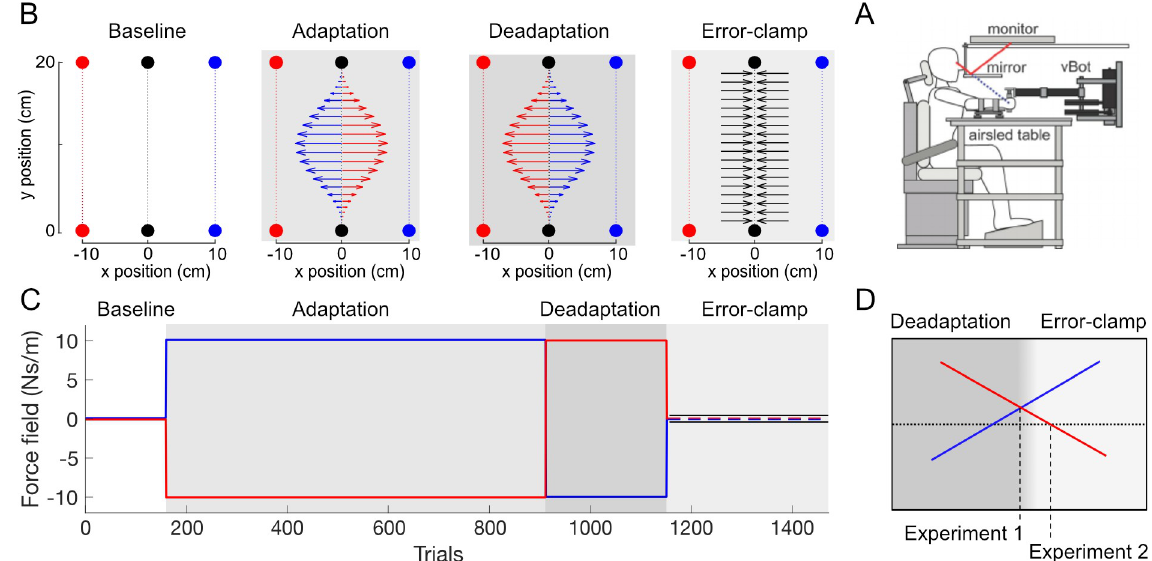
Fig 2. Experimental Setup and Paradigm. A. Workspace layout of the experiment. Participants always physically performed forward reaching movements in the center of the workspace (black). During these physical movements, the visual feedback (targets and cursor) was presented at one of two visual workspaces (red and blue) which acted as a contextual cue: -10cm offset (left workspace) set as cue 1 and +10cm offset (right workspace) set as cue 2. Red and blue colors are only used for illustration. On any one trial, only one of the visual workspaces was presented. In each phase of the experiment, different force fields were generated. In the pre-exposure phase, no external force was applied on the handle by the robot (null field trials). In the adaptation phase, two force fields were applied (CW and CCW), where each force field was always associated with one of the contextual cues (e.g. CCW force field for the left visual workspace and CW force field for the right visual workspace. In the de- adaptation phase, the association of the force fields to the visual cues was reversed (e.g. CW force field for the left visual workspace and CCW force field for the right visual workspace. In the error-clamp phase, all movements were performed in a mechanical channel for both contextual cues. B. Participants were seated and grasped the handle of the robotic manipulandum (vBOT) with their forearm supported by an airsled. Visual feedback of movements, displayed by the monitor, were viewed through a mirror so that they appear in the plane of movement. C. Temporal structure of the experiment. The different force field parameters depend on the experimental phase in order to create an A-B-error- clamp paradigm. In the error-clamp phase (light grey), the kinematic error is held at zero to assess spontaneous recovery. Trial numbers are shown for experiment 1. D. The participant-dependent transition from the de-adaptation to the error-clamp phase differed between the two experiments. In experiment 1, the participant’s predictive adaptation (force compensation) for the two cues had to cross one another. In experiment 2, the participant’s predictive adaptation was required to change sign (cross zero-line) for both cues.